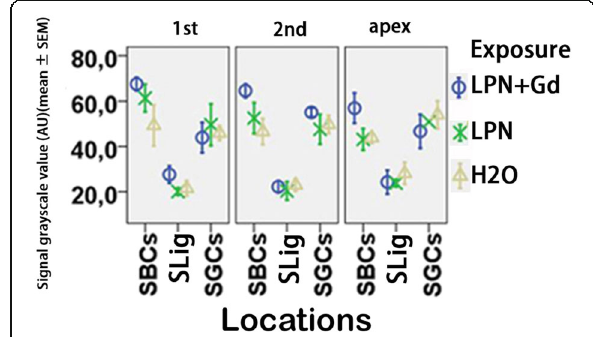
Fig. 10 Quantification of CD44 protein level in rat cochlea exposed to liposome nanocarriers detected using immunofluorescent confocal microscopy. There was insignificant difference among groups ( p >0.05, one-way ANOVA). n =3 in each group. n =3 in each group. AU arbitrary unit, H2O negative control, LPN empty liposome nanocarrier, LPN+Gd Gd-DOTA-containing LPN, SBCs stria basal cells, SGCs spiral ganglion cells, SLig spiral ligament, 1st basal turn, 2nd second